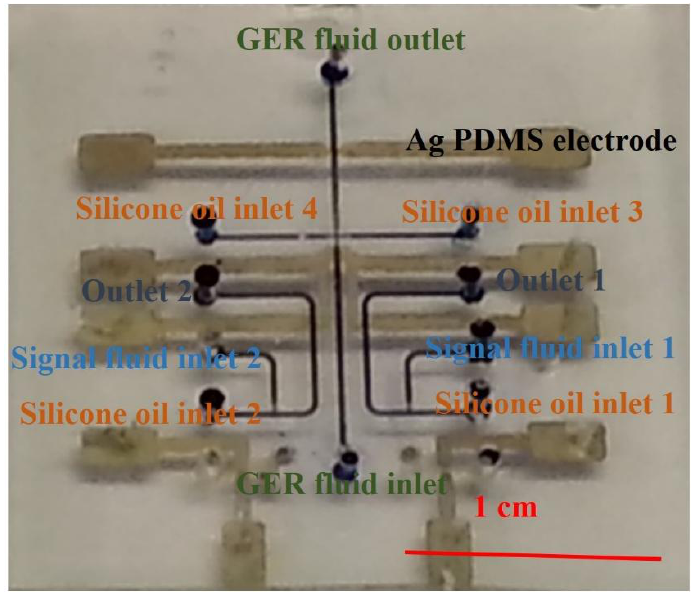
Figure 2. Optical image of the universal logic gate chip based on GER